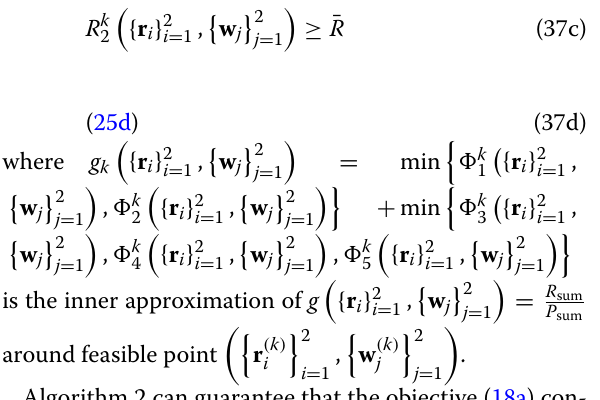
Algorithm 2 can guarantee that the objective (18a) con- verges to a KKT point by iterating the convex problem (37). In addition, the computational cost of problem (37)